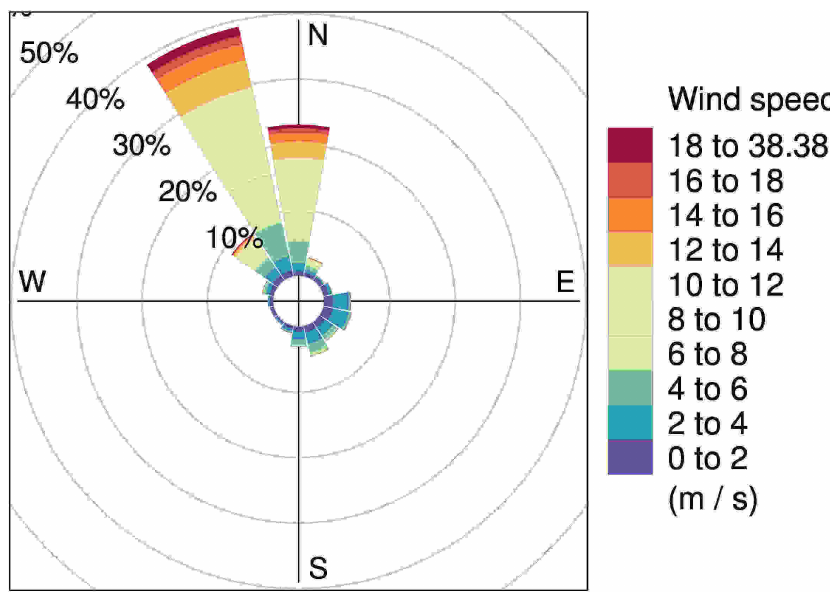
Figure 4. The wind rose shows that the wind speed and direction are distributed dominantly towards the north and north-northwest (N-NNW)